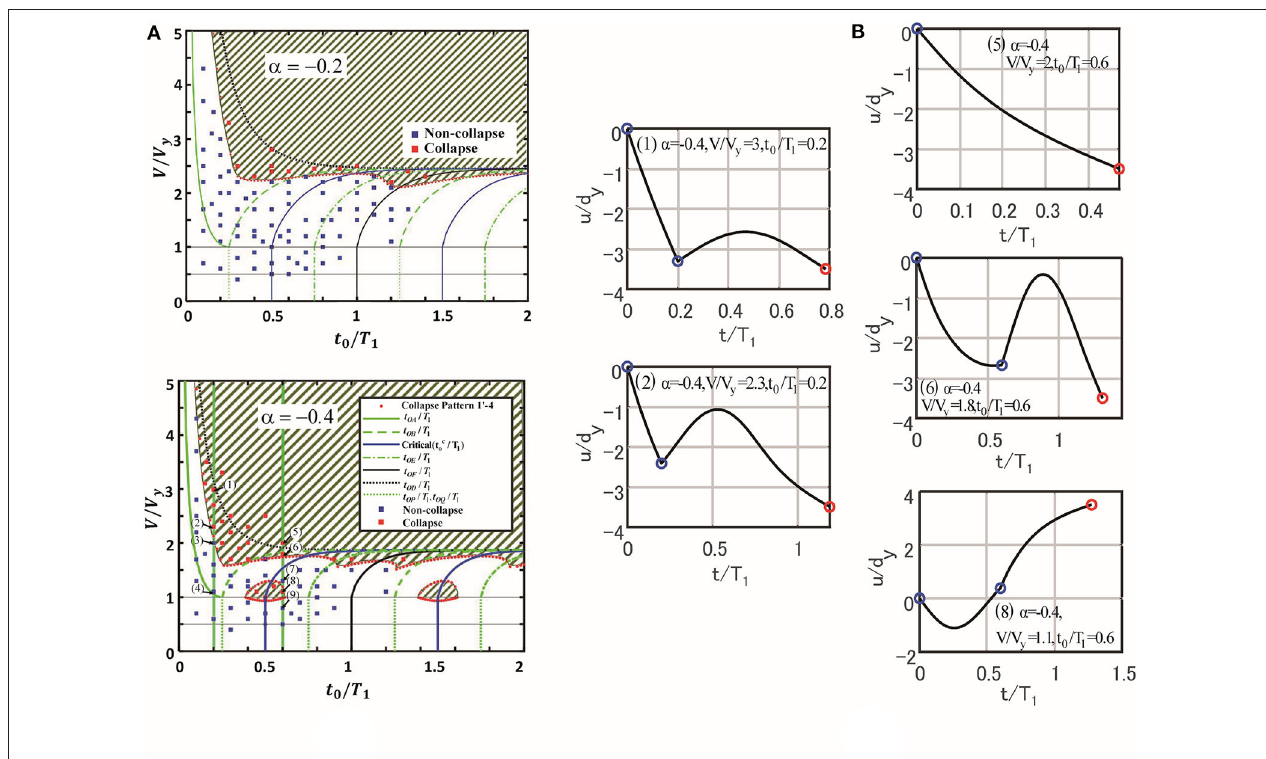
FIGURE 14 | Verification of the proposed collapse limit by time-history response analysis to double impulses with various input velocities and impulse timings. (A) Collapse and non-collapse plot for models with α (A) (blue marks indicate double impulse timings and red mark shows collapse